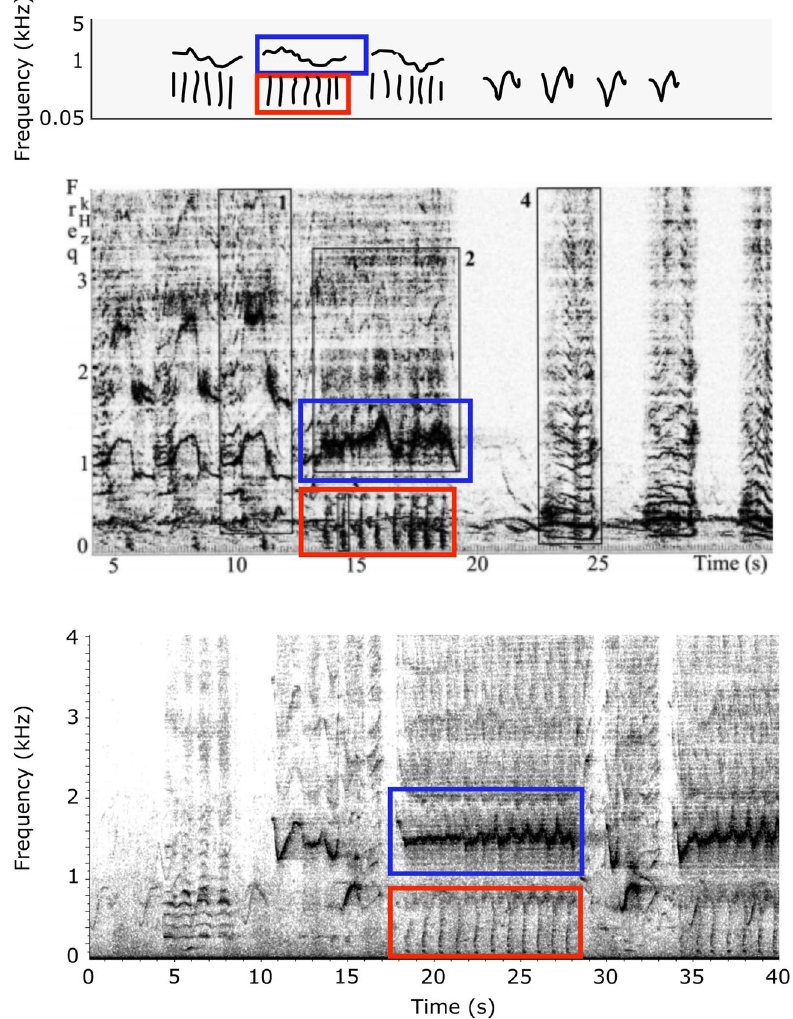
Figure 8. Examples of 3 bowhead whale songs displaying a highly similar biphonated unit. Top, song from the Chukchi Sea recorded in 1988 1 . Middle, song from the Chukchi sea recorded in December 2007 ( 3 adapted from, reproduced with the permission of the authors and the Acoustical Society of America). Bottom, song from the Greenland Sea recorded in December 2013 (this study). (Spectrogram parameters: 2048 pts FFT, 50% overlap, Hann window). The blue box corresponds to the long whistle-like vocalisation, with multiple inflections ( MSG11 described in this study). The red box shows the associated biphonation, a rapid sequence of shorts grunts or